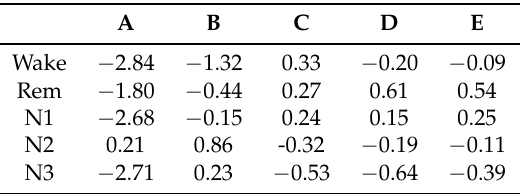
Table 5. Parameters of sleep